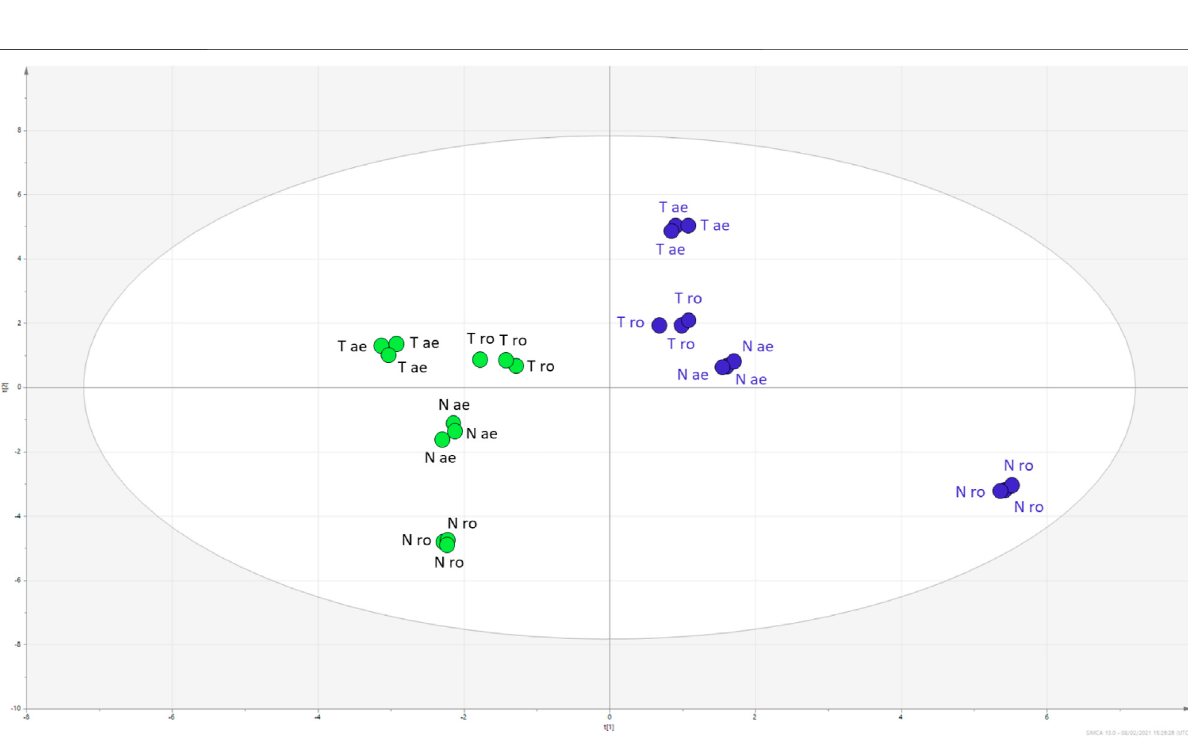
Frontiers in Pharmacology |